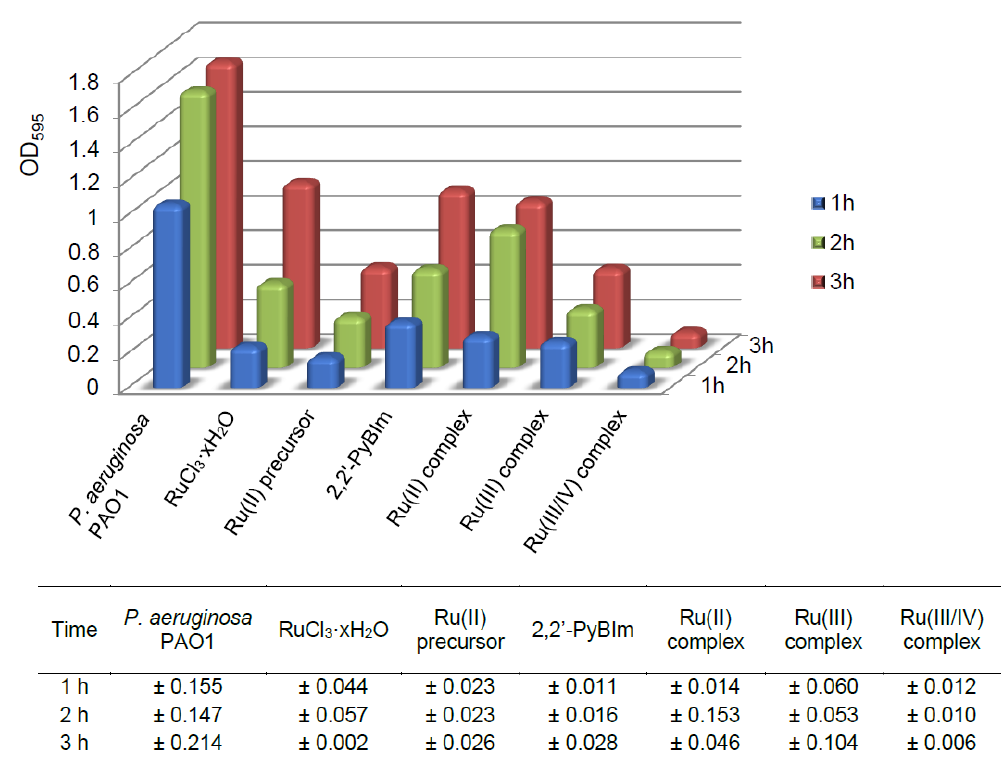
Figure 9. Monitoring early stage of P. aeruginosa PAO1 adhesion in the presence of the Ru complexes (after 1, 2, and 3 h) through quantitative analysis. The standard deviation are also pre- sented.